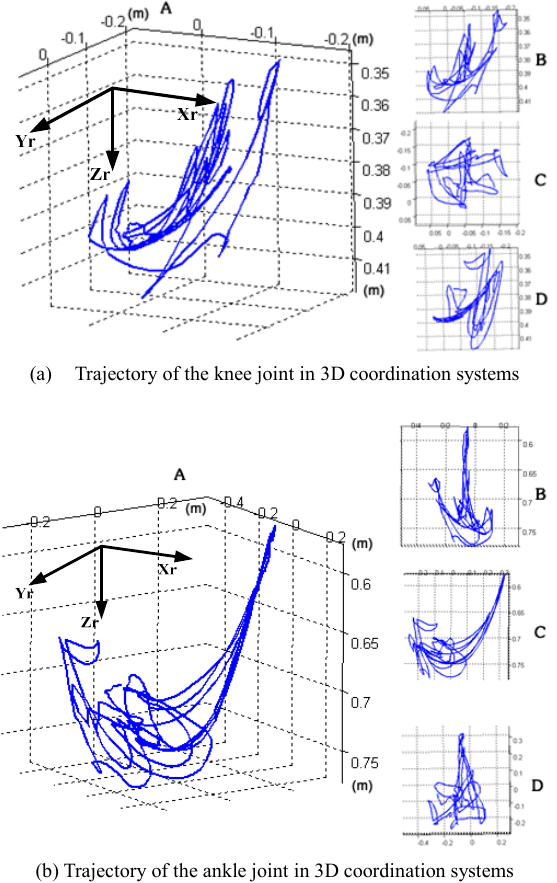
Fig.7 To visually estimate the lower limb gait posture using the data obtained by the developed wearable system, the calculated trajectories of the knee and ankle joints in the 3D local coordinate system ( Or-XrYrZr ) were showed on the left side marked as A in each picture. On the right side, the three smaller pictures marked as B , C and D were the detail information of the joint trajectory in the sagittal, transverse and frontal plane.